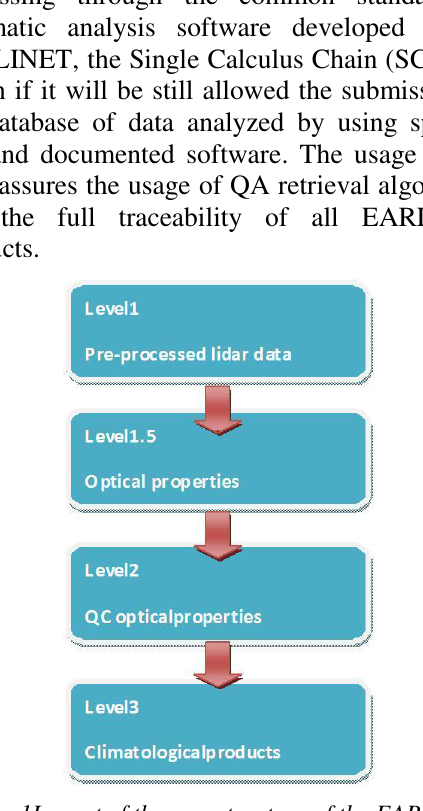
Figure 1Layout of the new structure of the EARLINET database.